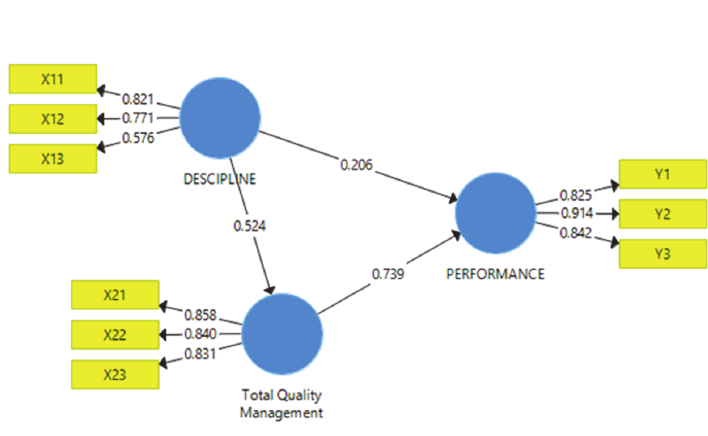
Fig. 2. Initial Partial Least Squares Model